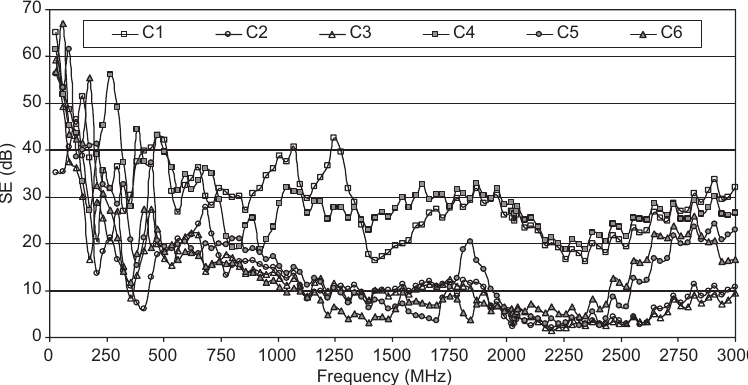
Figure 10 EMSE values of C1 to C6 composite